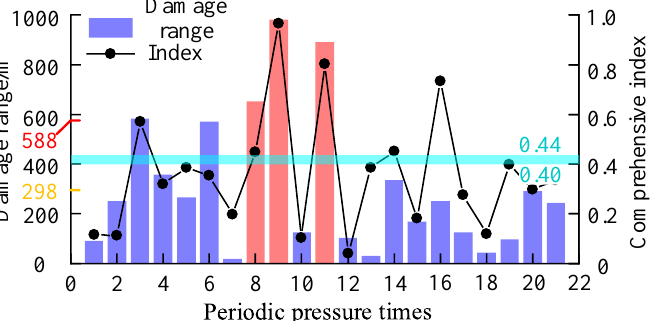
Figure 17. Comprehensive index early warning critical interval and efficiency ( “ medium ” ).